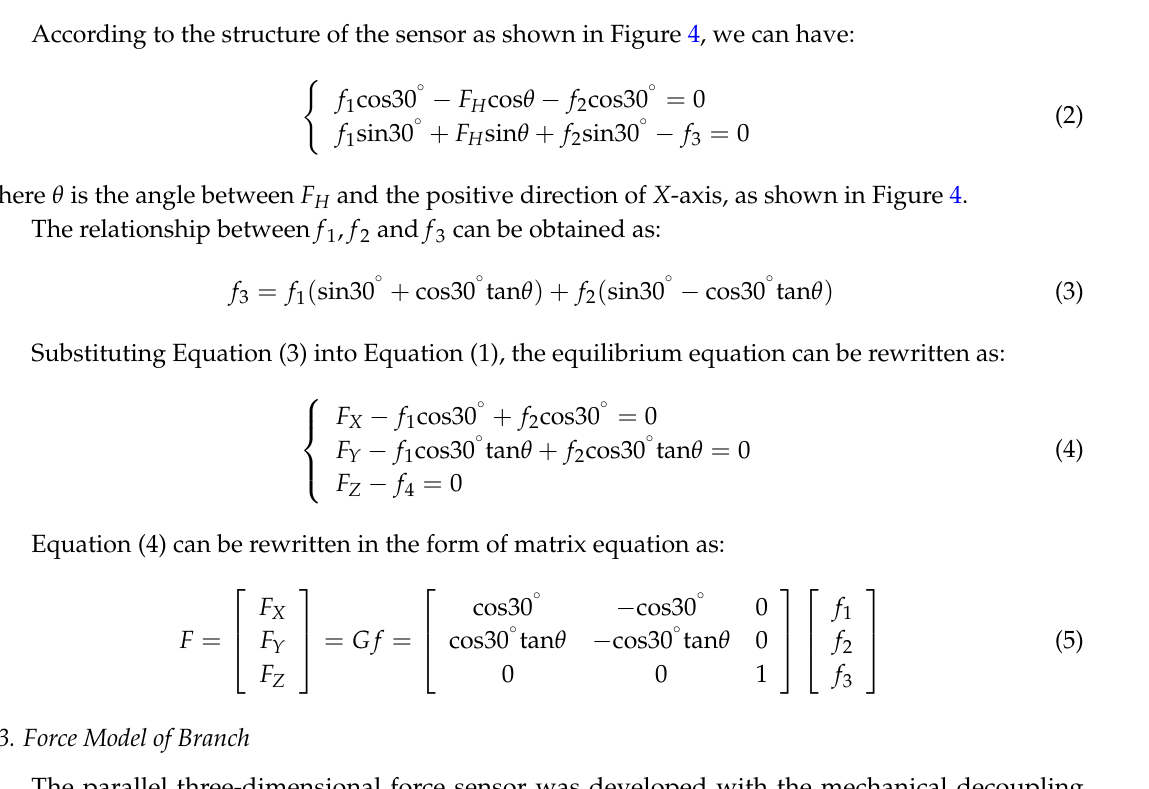
Figure 4. Force decomposition diagram of the sensor.